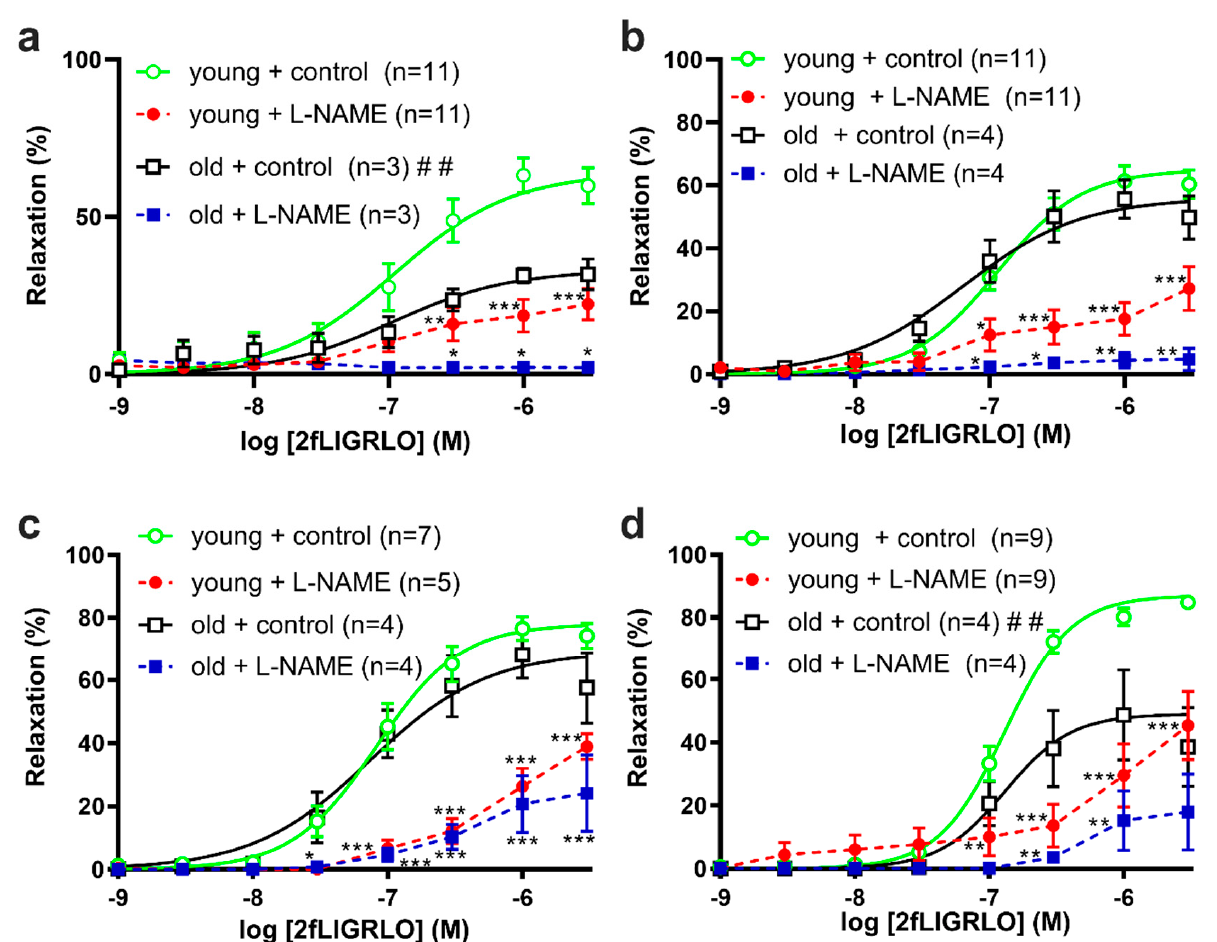
Figure 5. PAR2-specific agonist-induced relaxations of ( a ) proximal, ( b ) middle, ( c ) distal saphenous artery segments, and ( d ) caudal branches from (circle symbols) young and (square symbols) old Sprague Dawley rats. The results are expressed as mean ± S.E.M of ( n ) rats. Solid lines represent best-fit four parameter sigmoidal dose response curves for controls. Differences in best-fit curve parameters for controls were compared by Student’s t -test. ## p < 0.01, vs. E max young control. Differences in relaxations of control vs. L-NAME treatment were compared by 2way ANOVA with Bonferroni post hoc. * p < 0.05, ** p < 0.01, *** p < 0.001, vs. age-matched control.